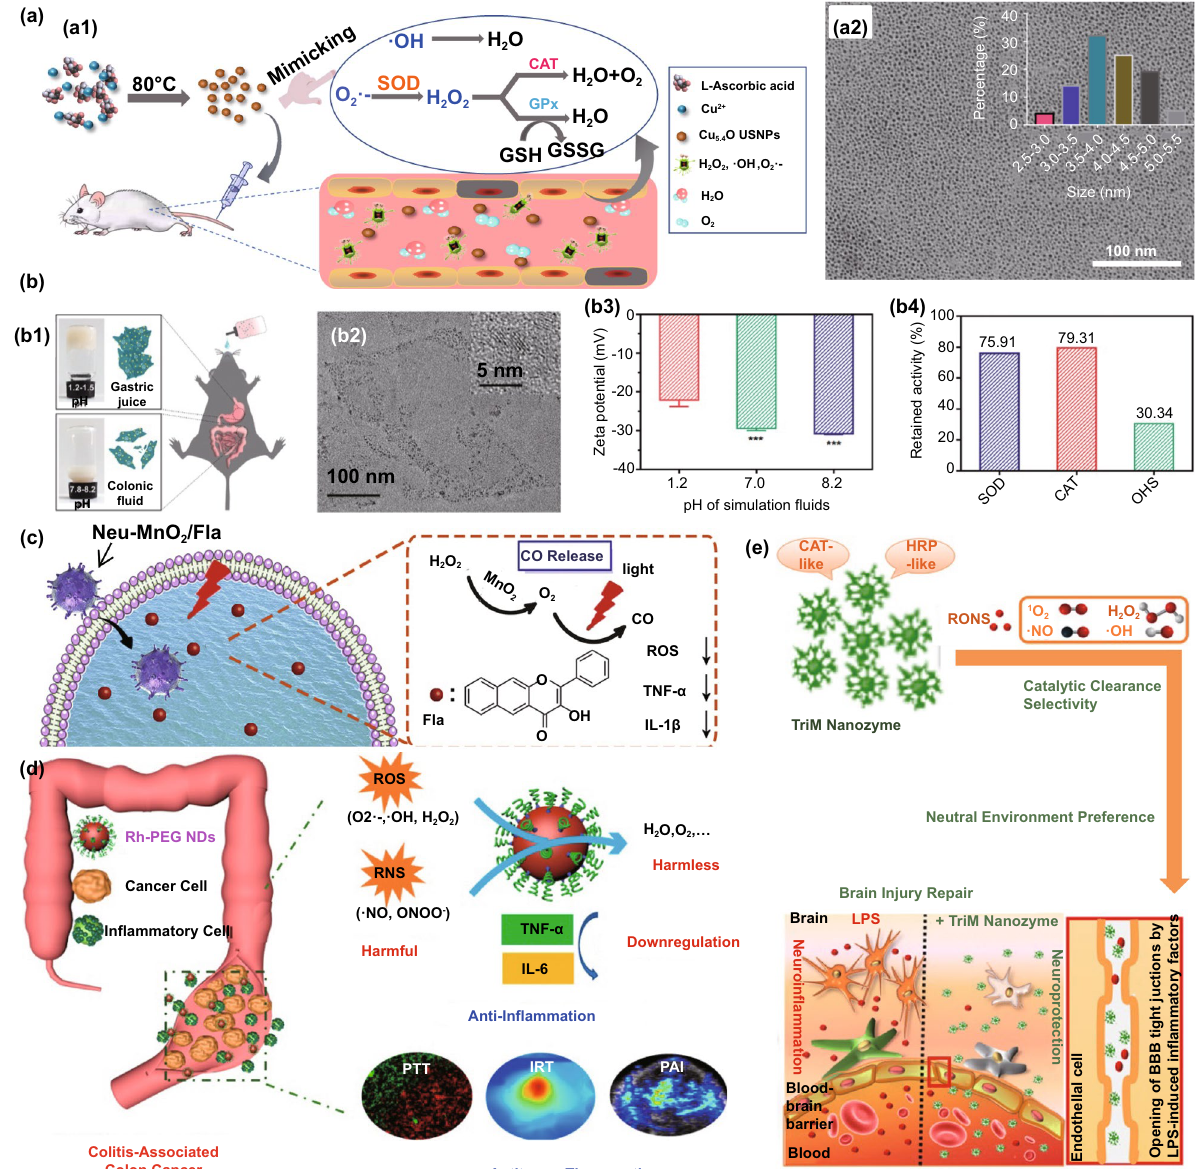
Fig. 10 a1 Schematic illustration of the ROS scavenging and anti-inflammation function of Cu 5.4 O USNPs with the mimic enzyme proper- ties of CAT, SOD, GPx ability. a2 TEM image and particle size distribution of Cu 5.4 O USNPs; b Stability and enzymatic activity of CeO 2 @ MMT(1:9). b1 Delivery process of CeO 2 @MMT through the simulated stomach (pH 1.2–1.5) and colon (pH 7.8–8.2) fluids via oral absorption. b2 TEM image of CeO 2 @MMT(1:9) after treating with HCl solution (pH≈1.2) for 4 h at 37 °C. b3 Zeta potentials of CeO 2 @MMT in simulated stomach and colon fluids. b4 CAT- and SOD-mimicking property and · OH scavenging activities (OHS) of CeO 2 @MMT treated with simulated gastric fluid. c The facilitated in situ CO release for synergistic anti-inflammatory effects induced by MnO 2 nanozymes modified with neutrophil membrane. d Rh-PEG NDs with excellent RONS scavenging ability, multi-enzyme-like activity and high photothermal conversion efficiency for relieving colon inflammation and anti-tumor treatment. e Application of PtPdMo nanozymes with multi-enzyme-like activity and high catalytic selectivity in improving neuroinflammation. PTT Photothermal therapy, PAI Photoacoustic imaging, IRT interventional radiotherapy. Adapted from a Ref. [392], b Ref. [394], c [395] d Ref. [396], e Ref [52] with